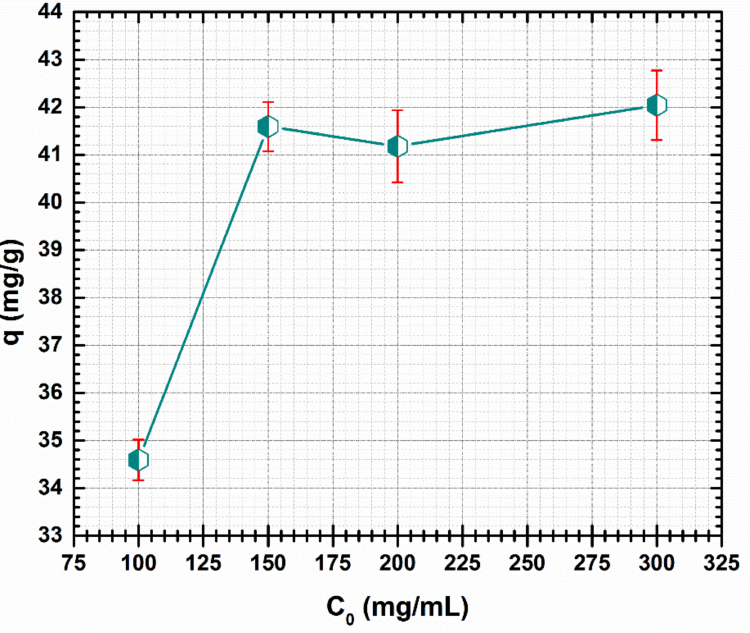
Figure 6. Effect of initial concentration on the adsorption of Cd (II) by CF@CMC. The maximum capacity uptake of CF@CMC are between 34.59 mg/g and 42.04 mg/g at initial Cd (II) concentrations range of 100–300 mg/L. It can be noted that a